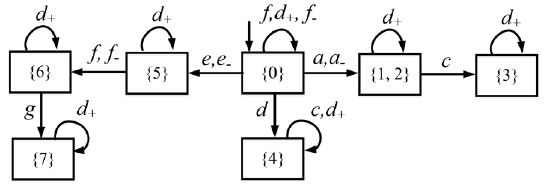
Figure 3. Attacker observer in Example 11 for the plant in Fig.